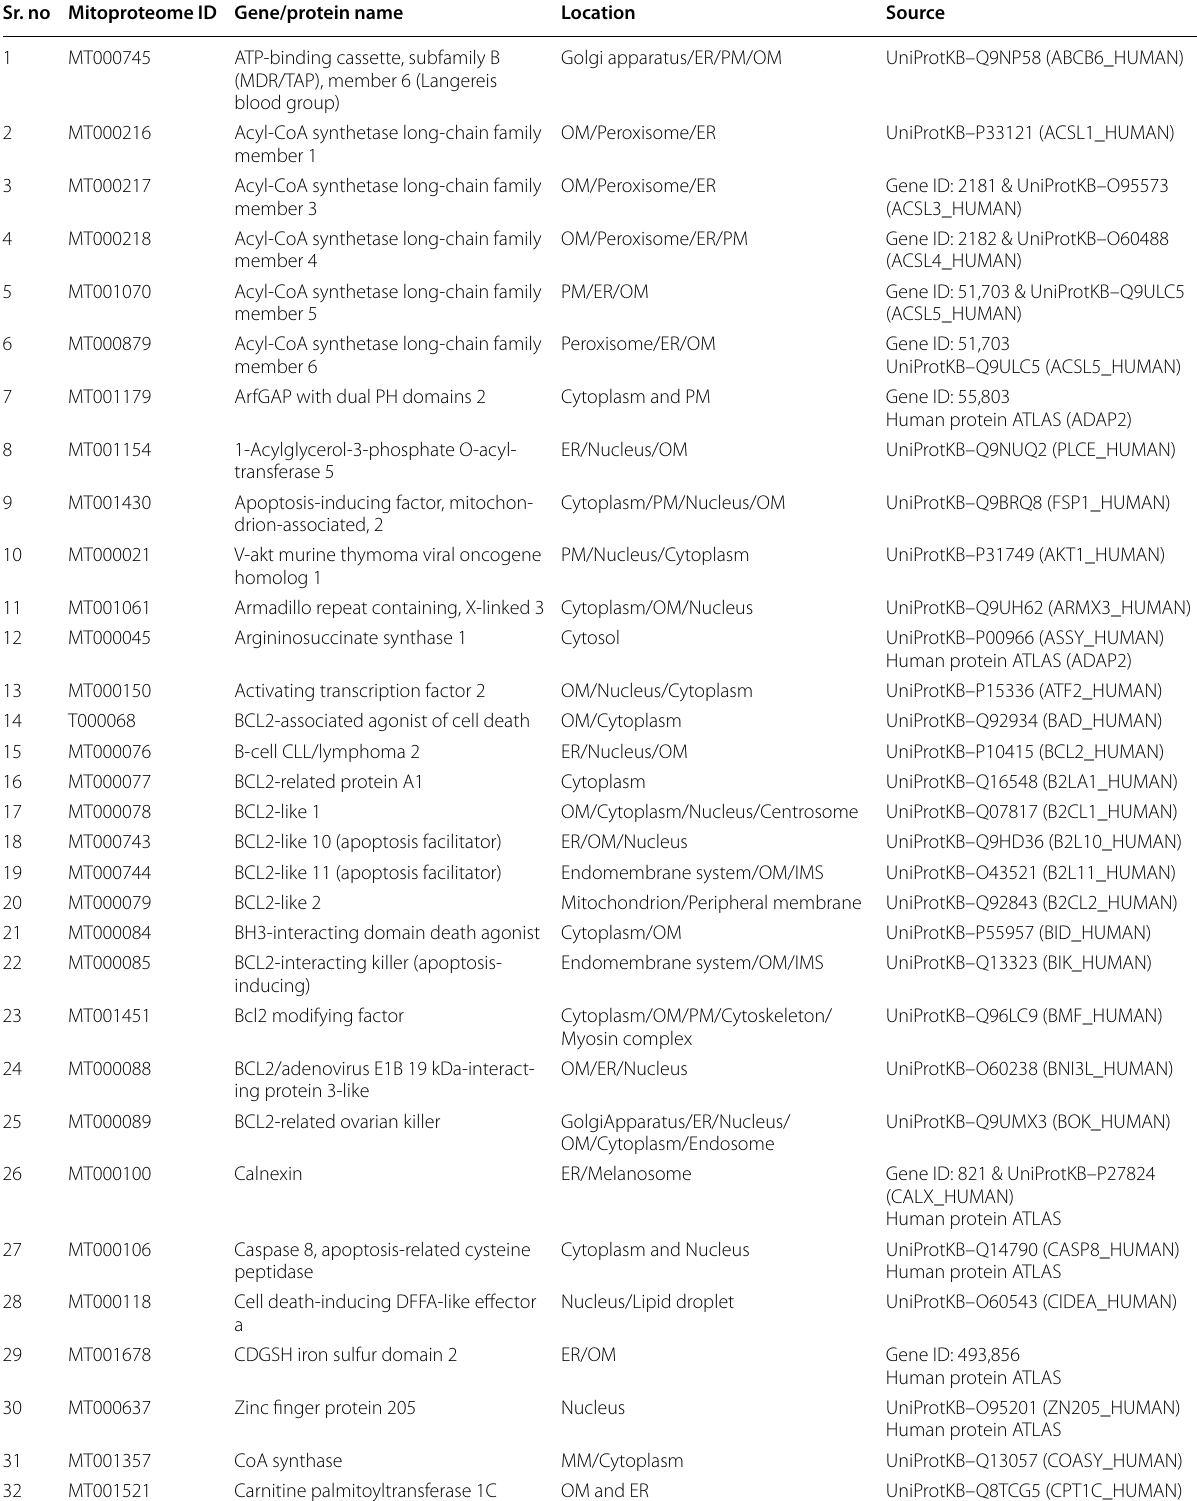
Table 2 List of proteins that are not present exclusively in mitochondria Sr. no Mitoproteome ID Gene/protein